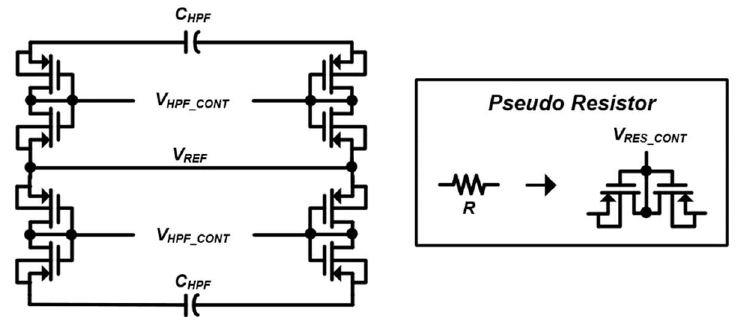
Figure 8. Structure of the floating HPF.